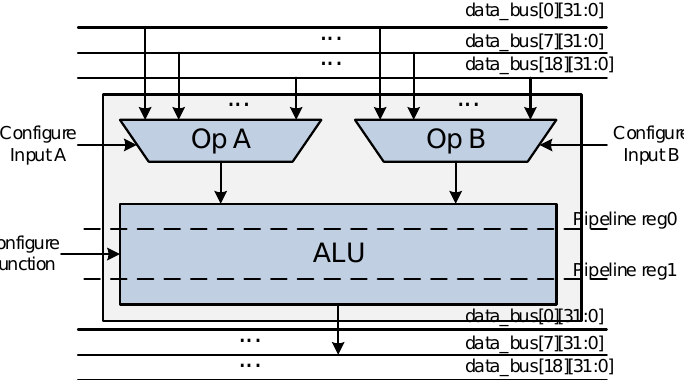
Figure 3. Functional unit